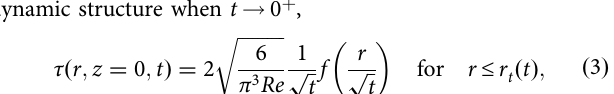
Fig. 4 Surface shear stress of drop impact. a The position of the lamellar tip r lm , the turning point r t , the maximum shear stress r s and the maximum pressure r p as a function of time t . The dashed line indicates r ¼ position of the maximum shear stress of drop impact r s ( t ) on substrates of different Young ’ s moduli and wettability. The error bars are the standard deviation of 15 experimental runs. c The rescaled surface shear stress τ = prediction of Eq. (3) with the modi fi ed scaling function f ( x ). d , e Two components of the surface shear stress: τ 1 = G ( ∂ u z / ∂ r ) ∣ z = 0 and τ 2 = G ( ∂ u r / ∂ z ) ∣ z = 0 . f The total surface shear stress τ = τ 1 + τ 2 . The shear stresses in ( c – f ) are nondimensionalized by ρ U 2 and share the same color code for time, as indicated in ( c ). The diameter and the impact velocity of the liquid drop are D = 3.49 mm and U = 2.97